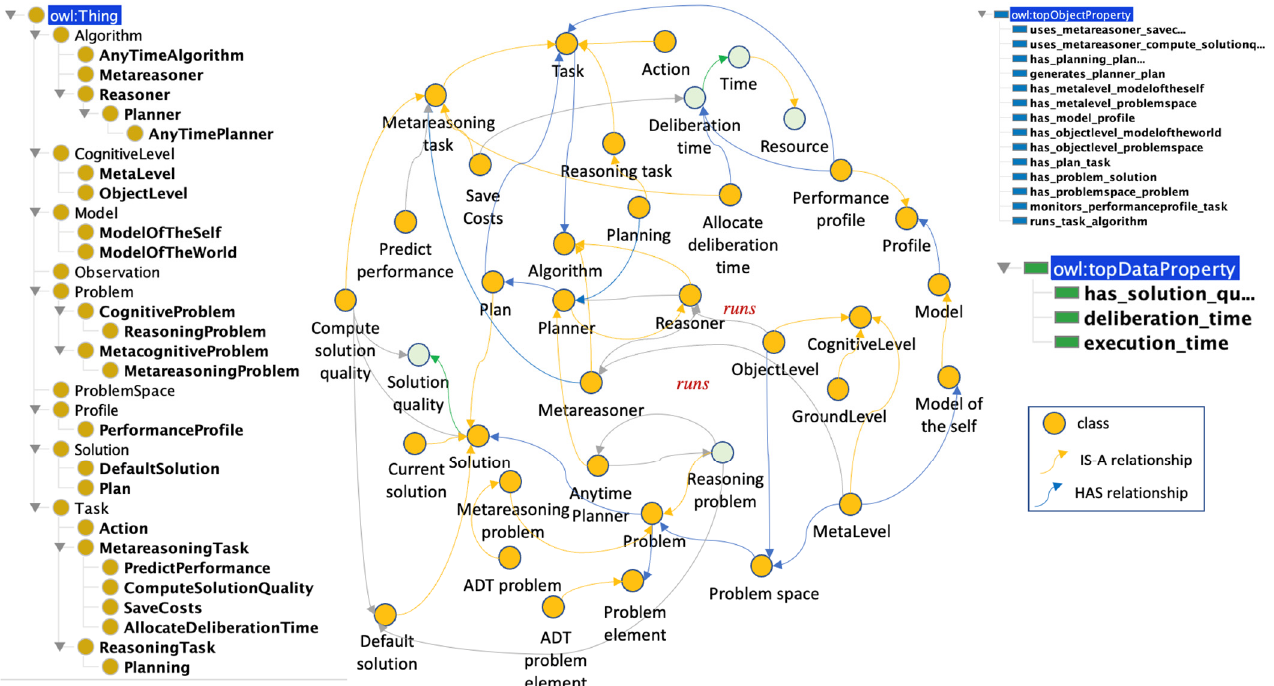
Figure 6. ADTP subontology.